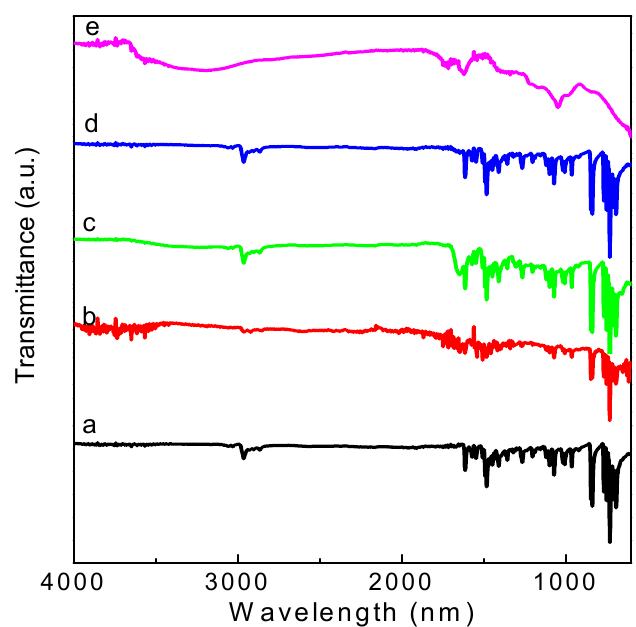
Figure 7. Fourier-transform infrared spectroscopy (FTIR) spectra of ( a ) PBD, ( b – d ) PBD:GO composites with chemical components of weight ratio 2:1, 5:1 and 10:1, respectively, ( e ) GO.